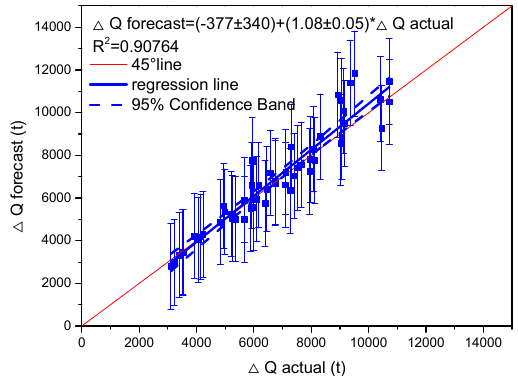
Figure 8. Intersection diagram of simulation data and verification data.